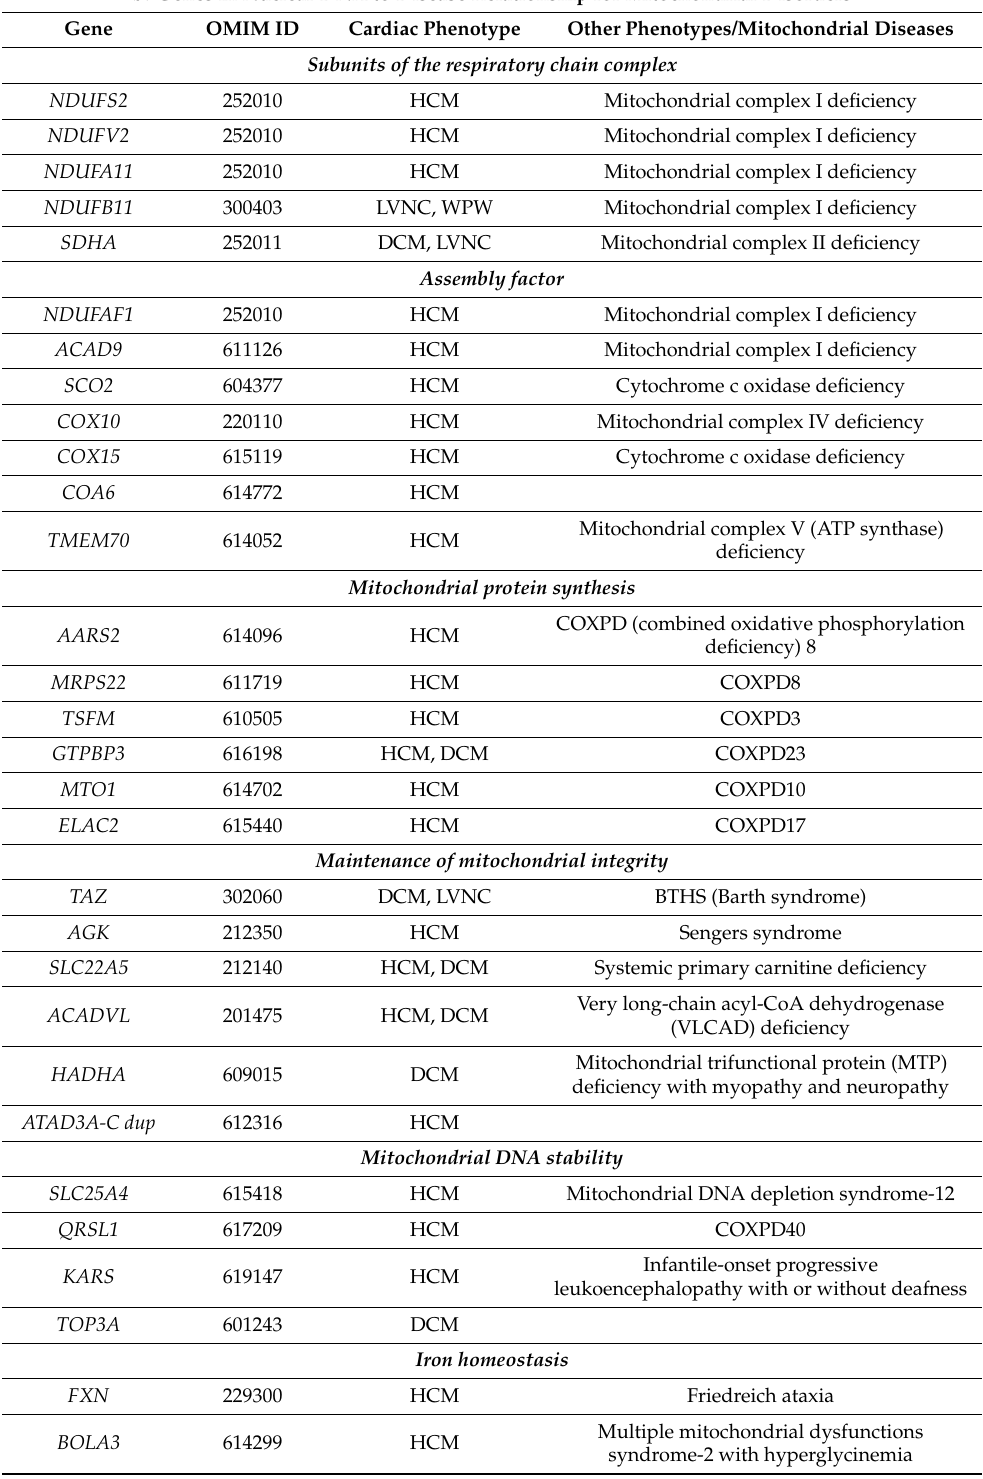
b. Genes in Nuclear DNA to Disease Relationship for Mitochondrial